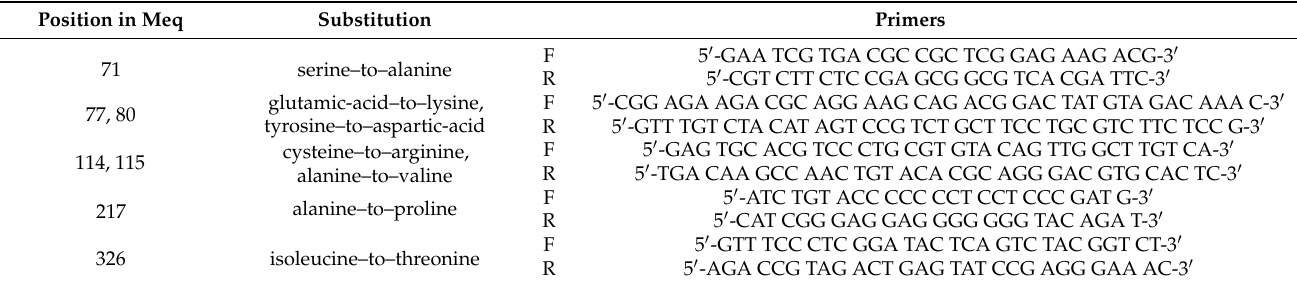
Table 1. Introduction of the mutation into the S- meq and/or L- meq